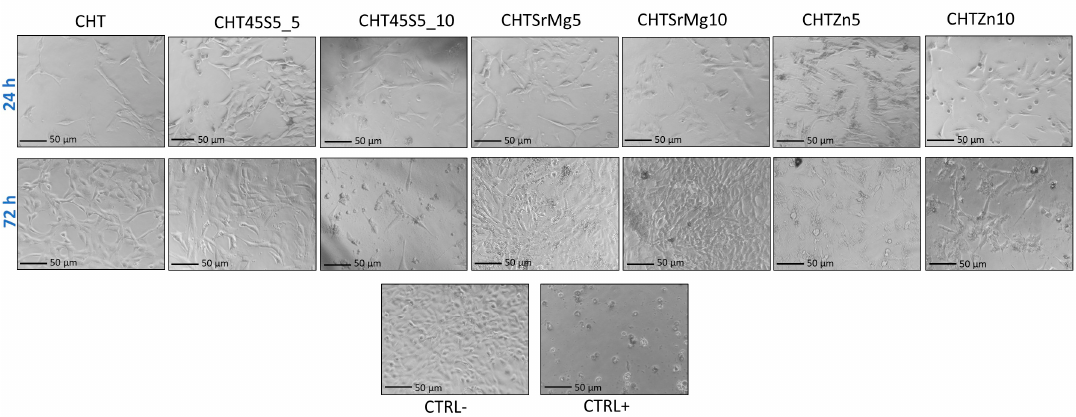
Figure 5. Morphological evaluation of cells (NIH 3T3) 24 and 72 h after seeding in direct contact with wound dressings by optical microscopy (Nikon TMF, Kumagaya, Japan); 50 × magnification.